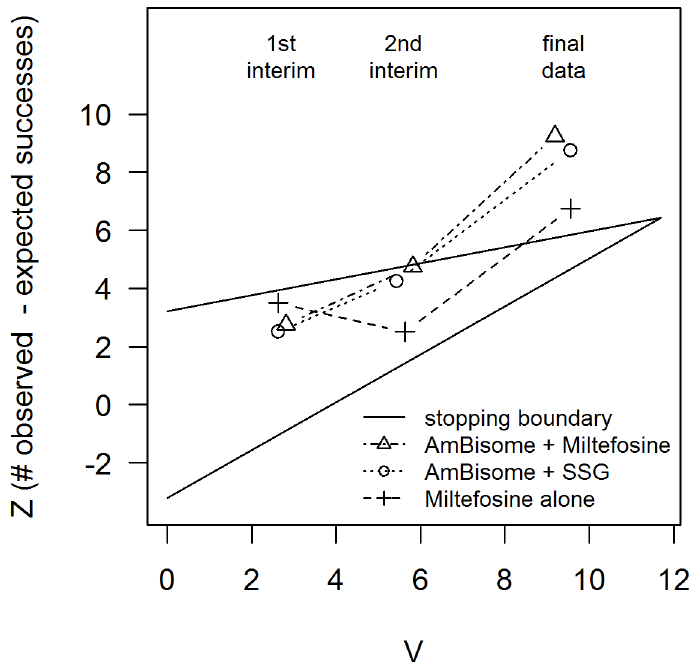
Fig 2. Sequential stopping for the three arms. The horizontal axis ( V ) is proportional to sample size. The vertical axis ( Z ) is the observed minus expected number of cures, so higher values are more favourable. Each arm is shown by a line with three points representing, from left to right, the first interim analysis (decision: continue for all arms), the second interim analysis (decision: continue for all arms) and the final analysis. The final analysis (shown here) includes patients whose follow-up was still in progress at the time of the third interim analysis, and confirmed the ‘ stop ’ decisions. Having all stopped at the same analysis, the point estimates of proportion cured are the same for all arms (85%), as are the 95% confidence intervals (77 – 97%). Based on the probability tree method, the point estimate at day 210 for AmBisome + SSG is 87% (95% CI 77 – 97%); for AmBisome + Miltefosine it is 77% (64 – 90%) and for Miltefosine 72% (60 – 85%).